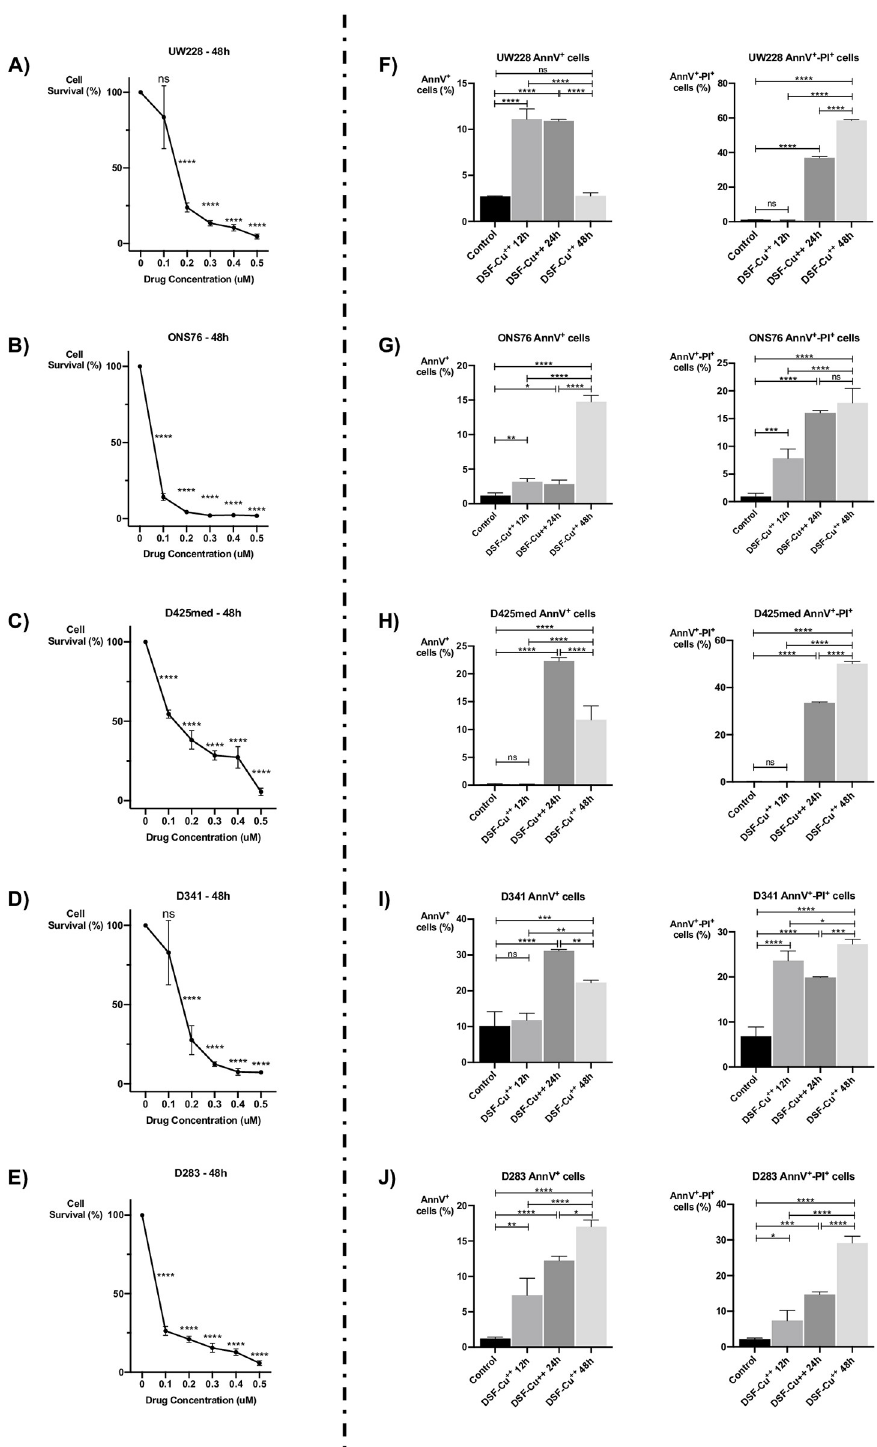
Fig 1. DSF-Cu ++ induces cells death and apoptosis in Shh-driven and Group 3 medulloblastoma. (A-B-C-D-E) cytotoxicity assays with different concentrations of DSF-Cu ++ in ONS76, UW228, D341, D425med and D283 cells. IC50s were between 100nM and 200nM in all the lines. (F-G-H-I-J) assessment of early and late apoptotic cells with AnnV-PI in the same cell lines. A significant increase in AnnV + -PI - cells was found at 12-24h post-treatment, while a larger fraction of AnnV + -PI + cells was noticed after 24-48h of treatment with an equimolar dose of 150nM DSF-Cu ++ .